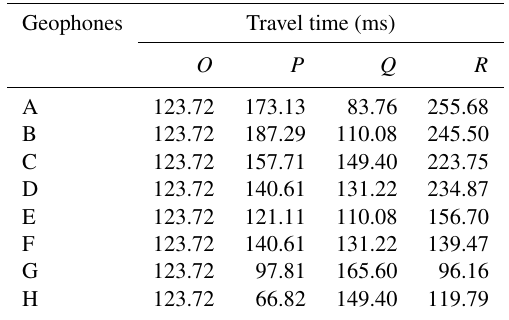
Table 2. Travel time of a microseismic